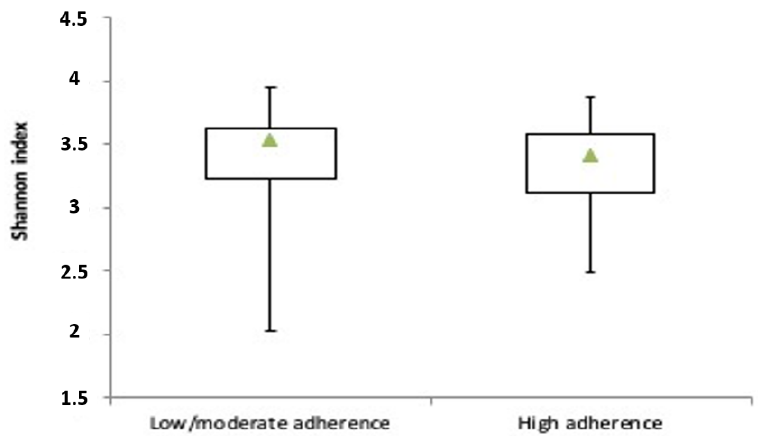
Figure 1. Alpha-diversity metrics in low / moderate adherence and high adherence to the Mediterranean diet groups. Box plots of species-level Shannon diversity index.